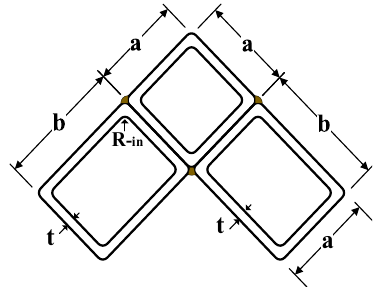
Figure 9. Definition of the cross-section parameter.